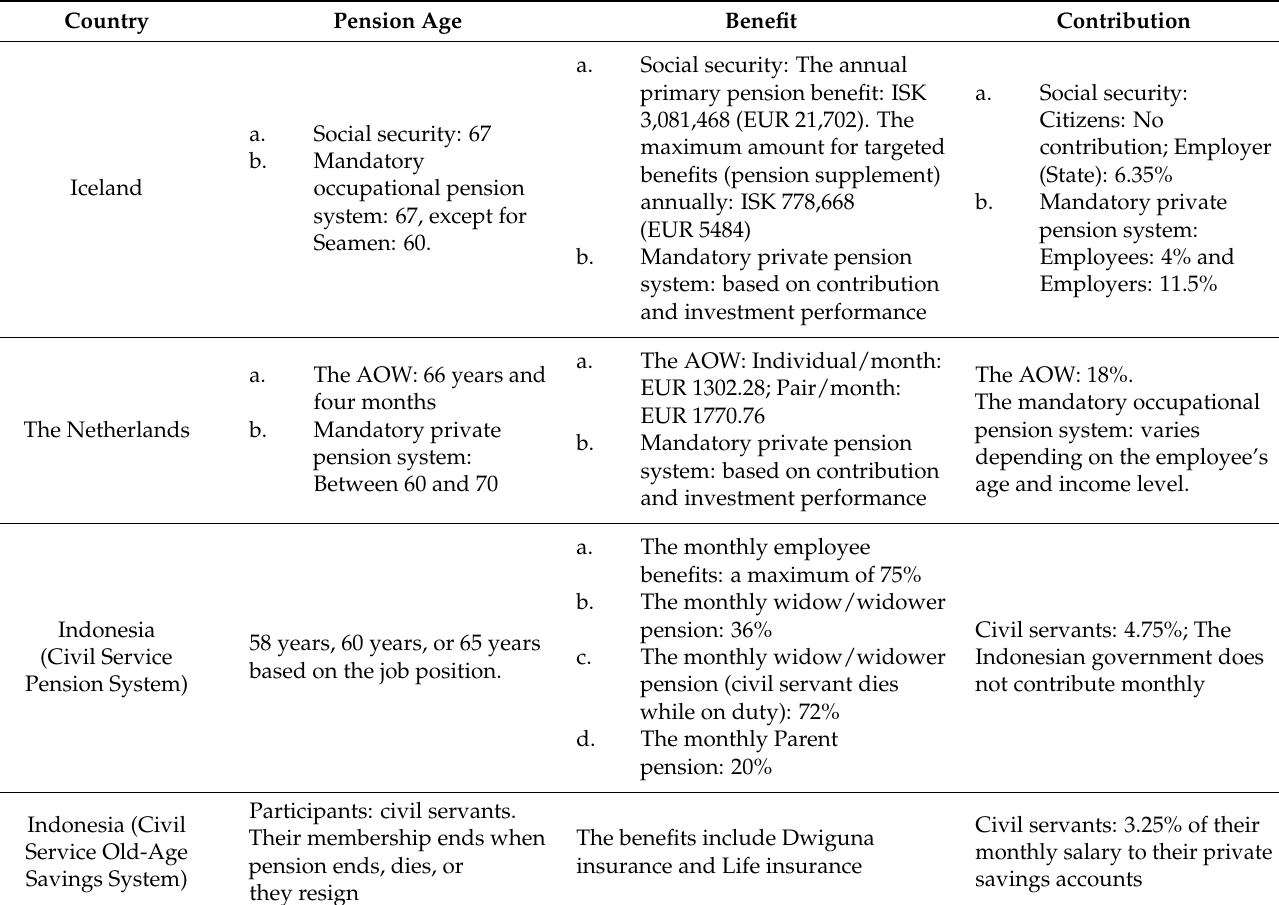
Table 3. Comparison of Pension Parameters in Iceland, the Netherlands, and